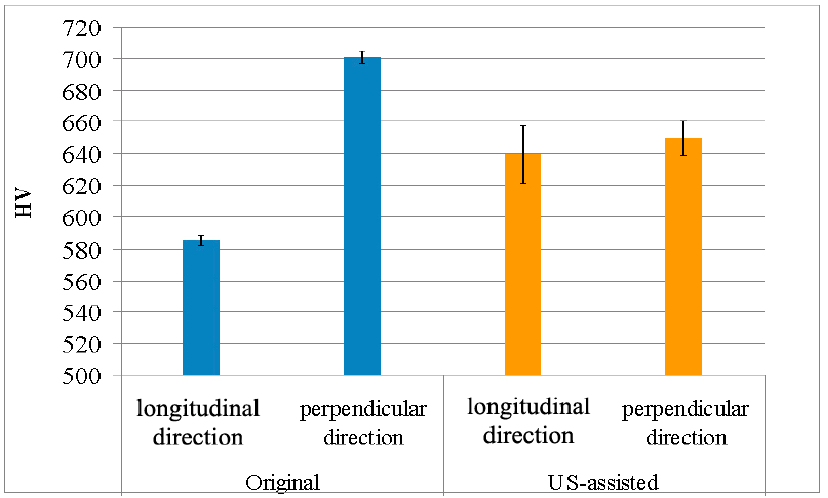
Figure 13. Effect of US on the Vickers hardness (HV0.5), shown for two directions: the longitudinal and perpendicular directions with respect to the substrate.